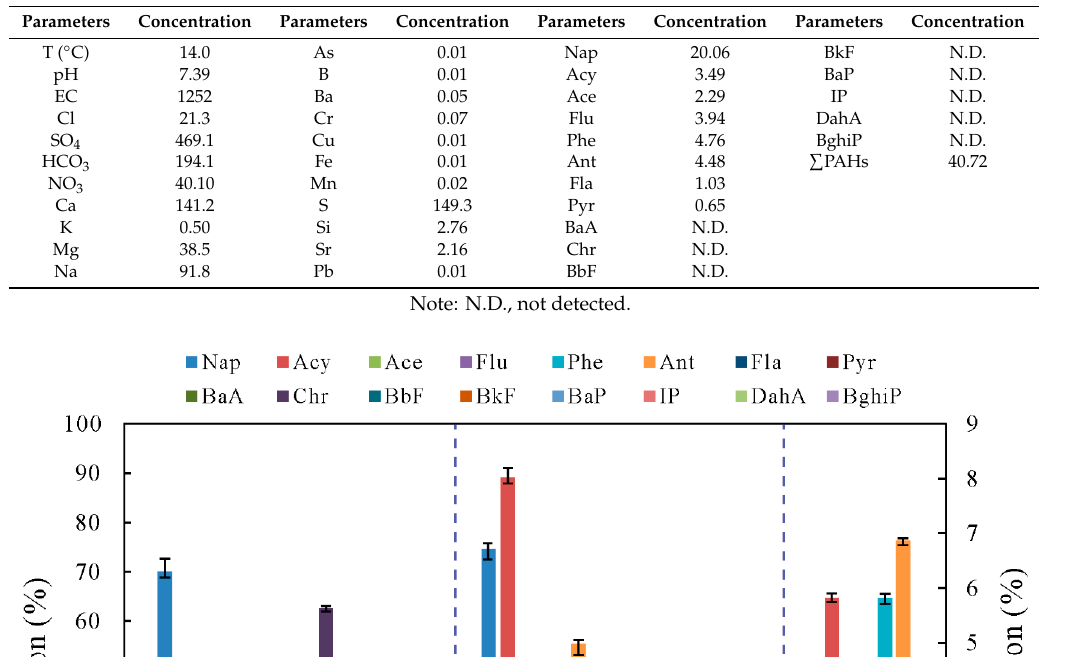
Table 2. Chemical data and in situ physic-chemical parameters of the leachate sample collected in the field (concentration of ions in mg/L, PAHs in ng/L).